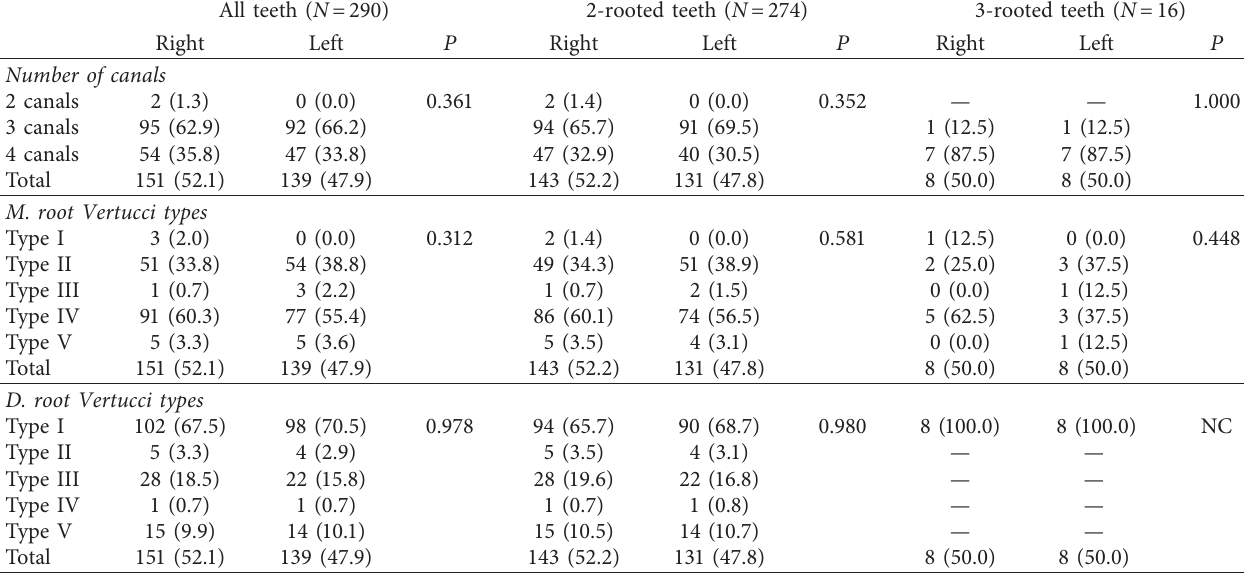
Table 2: Comparison amongst right and left edges among mandibular 1 st molars N (%).